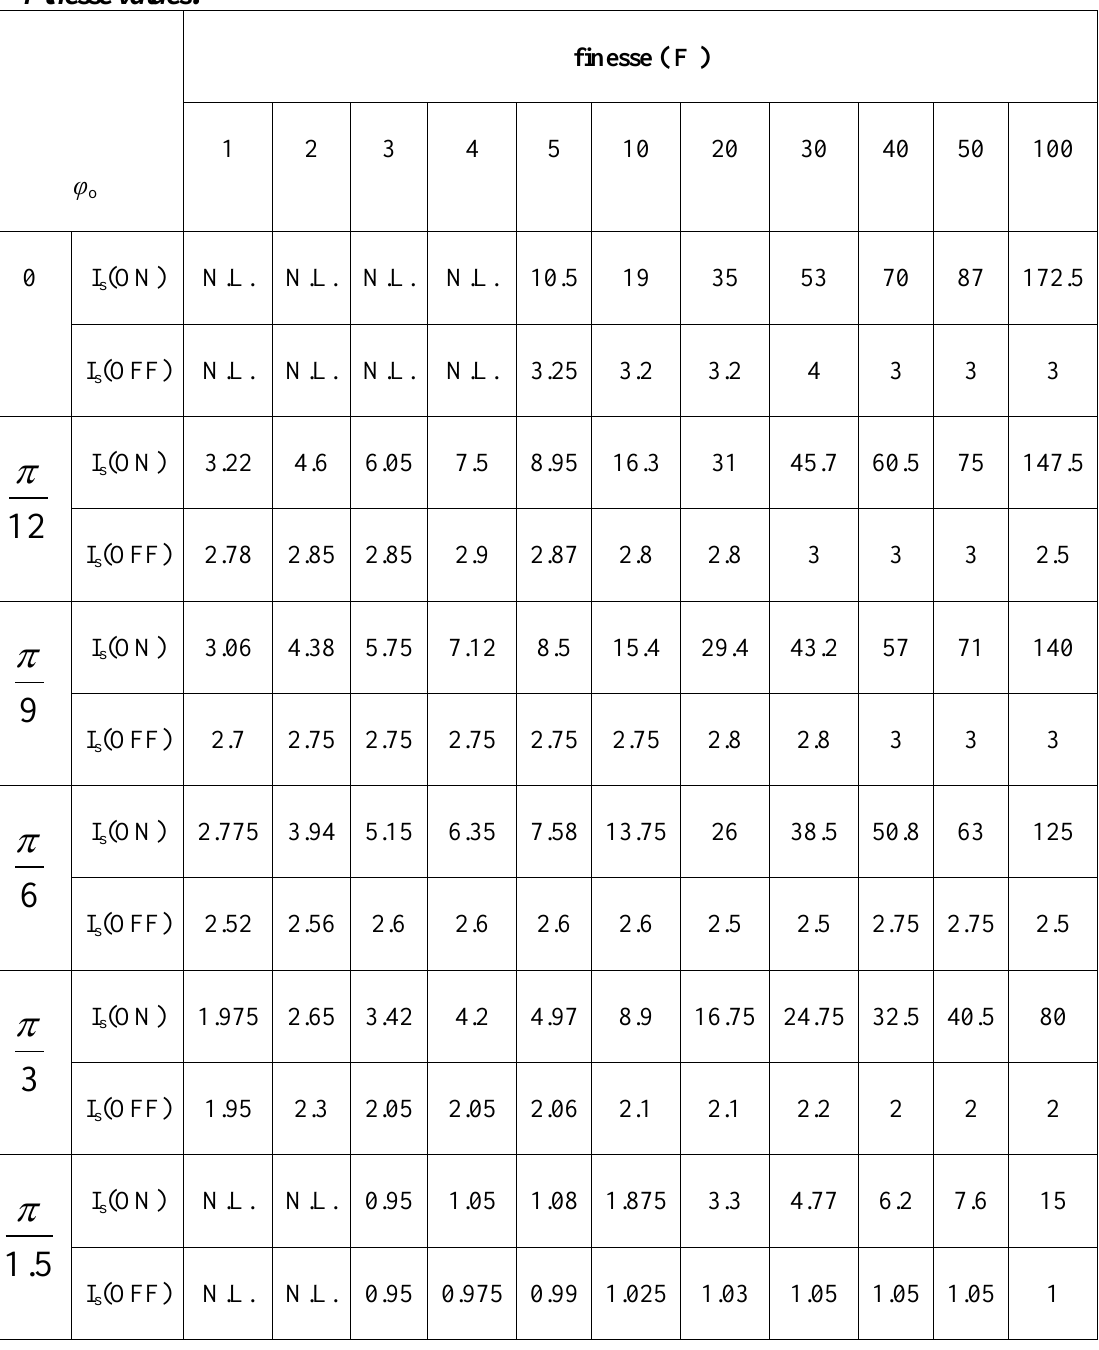
Table 1: The switch-ON and switch-OFF points for each value of initial detuning and Finesse